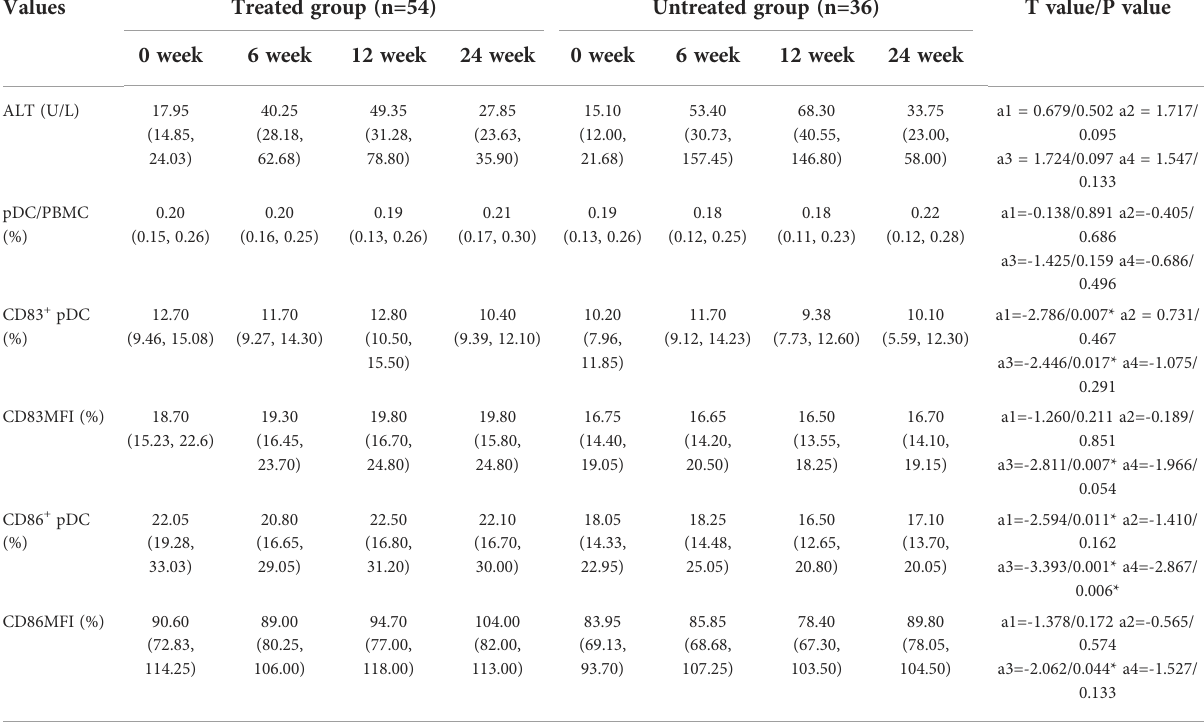
TABLE 4 Comparison of ALT and pDC levels at different time points between two groups. Values Treated group